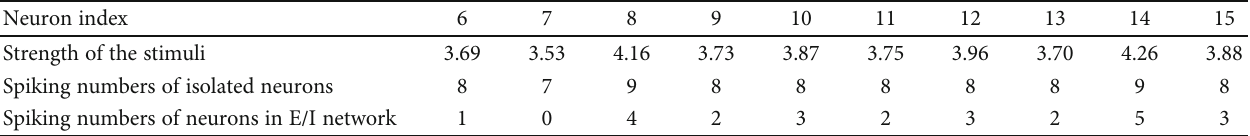
Table 2: Spiking numbers of 10 isolated neurons and 10 excitatory neurons in E/I networks (see Figures 5(a) and 6(a)) with noise. Neuron index